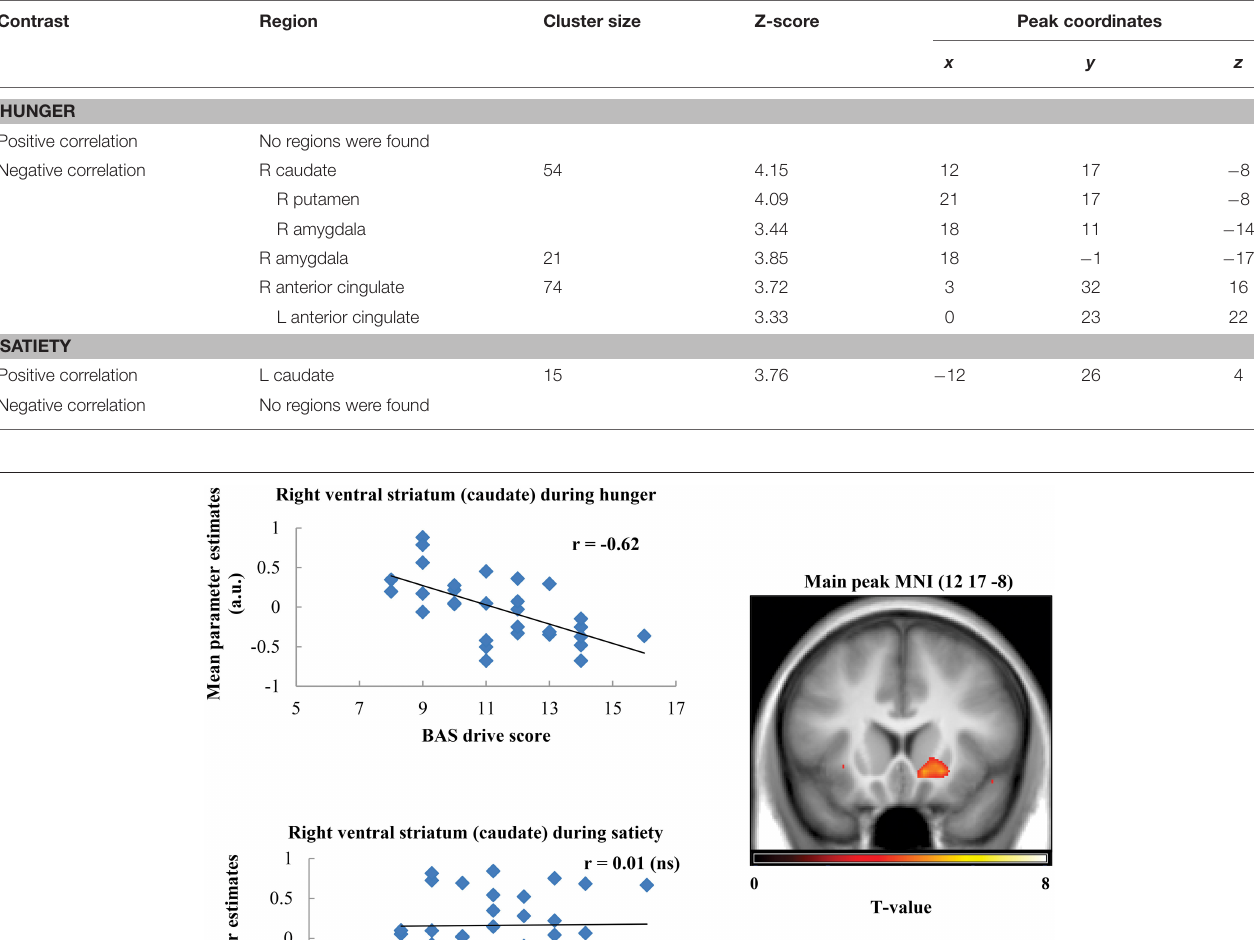
TABLE 3 | ROIs in which brain activation by oral calories (maltodextrin and sucralose minus sucralose) correlated significantly with reward sensitivity (BAS drive score) during hunger and satiety. Contrast